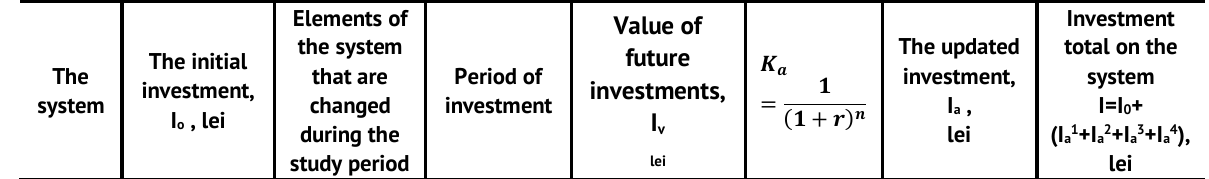
Variant B. Determination of total investments for the Chiller-fan coil system